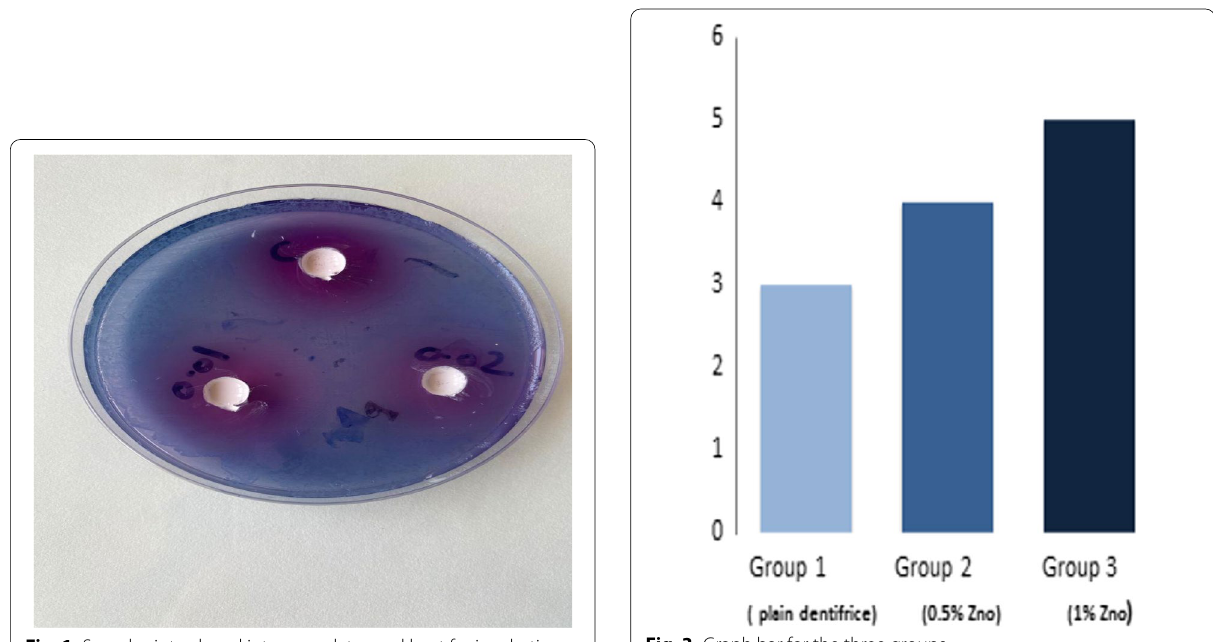
Fig. 3 Graph bar for the three